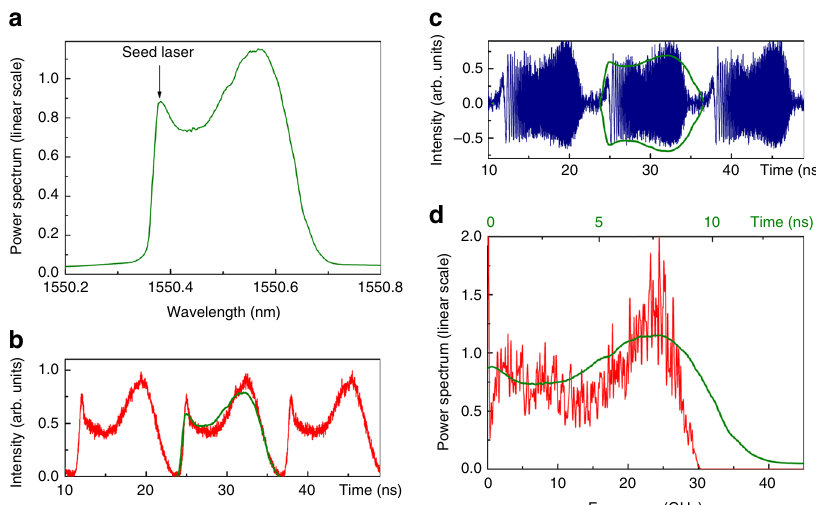
Fig. 5 Evidence of frequency-to-time mapping at the output of the FSL. a Optical power spectrum generated in the FSL, in linear scale (the comb lines are not resolved). b In red: intensity measured at the output of the FSL, compared to the time-mapped optical power spectrum (green). c In blue: intensity measured after recombination with the seed laser, compared to an envelope pro fi le mapping the square root of the optical power spectrum (green). d In red: spectrum of an individual chirped waveform extracted from c , in linear scale, compared to the time-mapped optical power spectrum (green). The spectral traces represented in b – d (green curves) are mapped into the time domain following Eq. (5), where the effective dispersion D is calculated from Eq. (3) using the de fi ned operation parameters, namely = 5.06 × 10 − 20 s 2 . All traces are single-shot (no averaged)